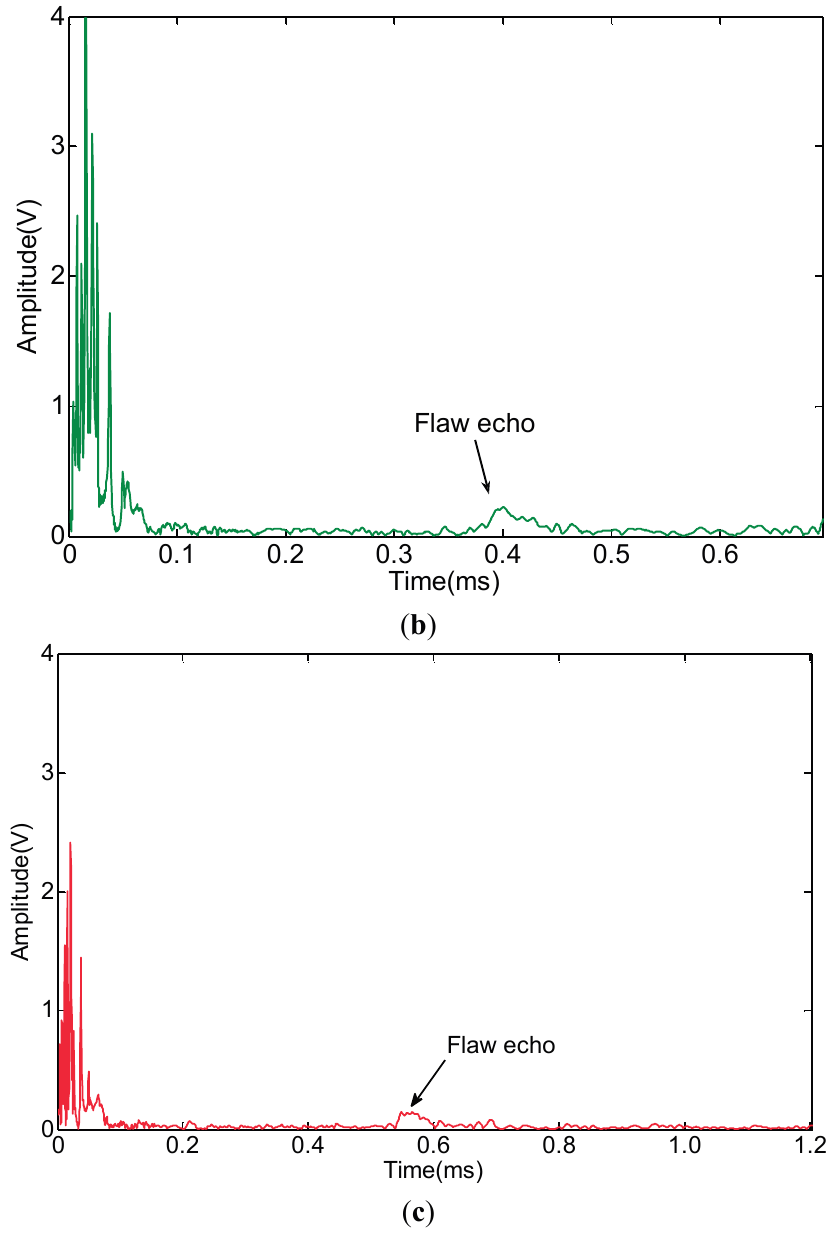
Figure 10. Waveform of the axially and non-axially symmetric modes obtained by processing the data shown in Figure 8: ( a ) L(0,2) mode; ( b ) F(1,3) mode; ( c ) F(2,3)